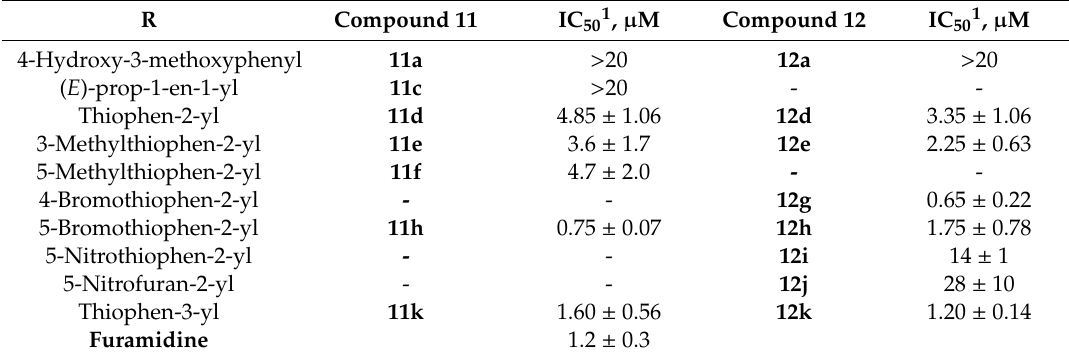
Table 2. TDP1 inhibition potency of the 3-carene